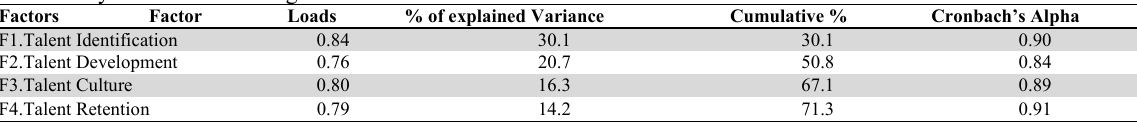
Factor Analysis of Talent